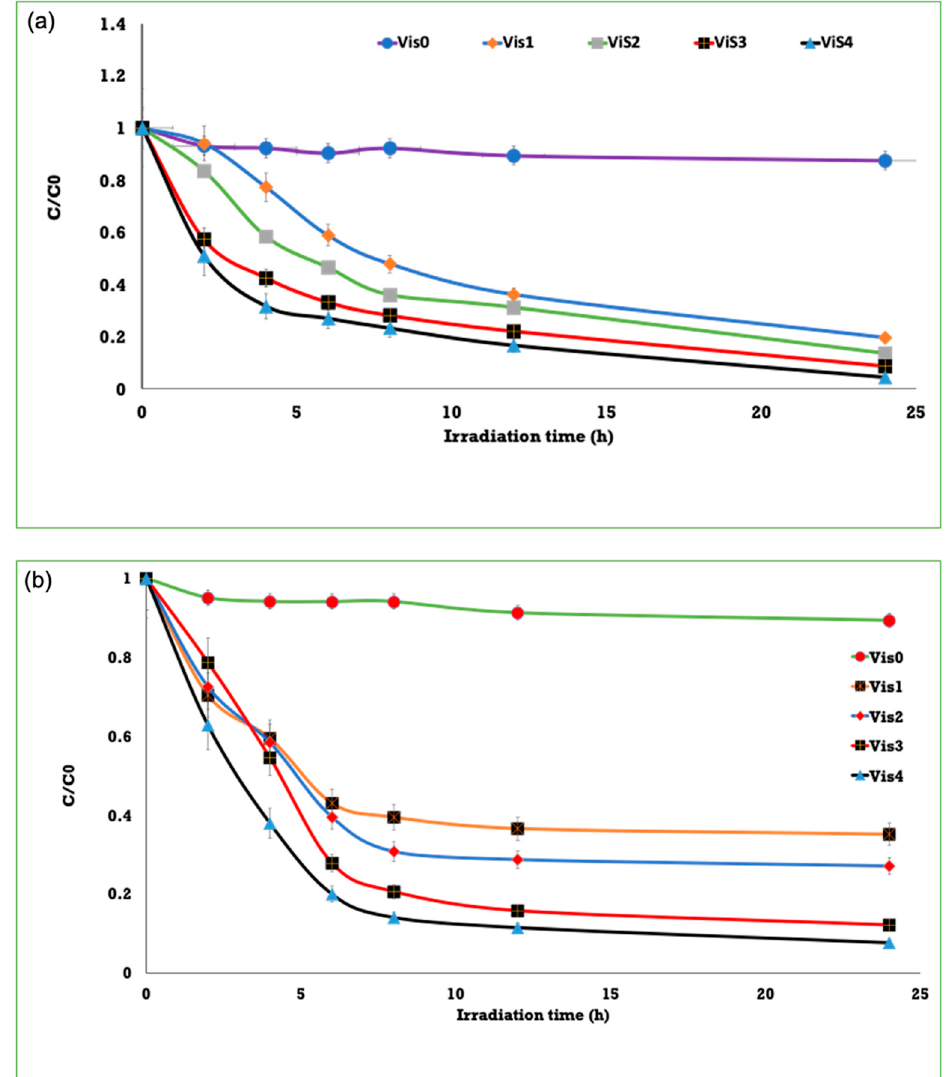
Figure 6. Degradation of MTC on fibers under UV (a) and visible (b) lights for pristine fibers (Vis 0 ), TiO 2 /fibers after wash (Vis 1 ), TiO 2 /fibers before wash (Vis 2 ), Ag 0 /TiO 2 /fibers after wash (Vis 3 ), and Ag 0 /TiO 2 /fibers before wash (Vis 4 ).